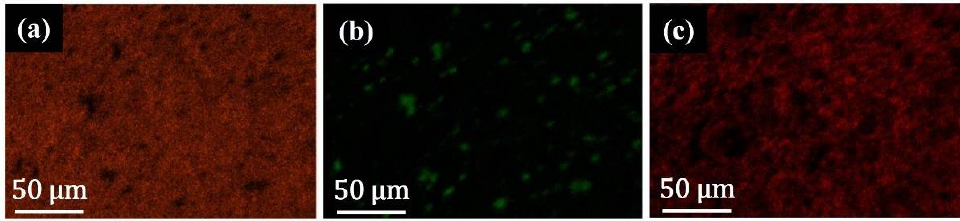
Figure 6. The elemental distribution of ( a ) zinc; ( b ) bismuth; and ( c ) oxygen in the zinc electrode.